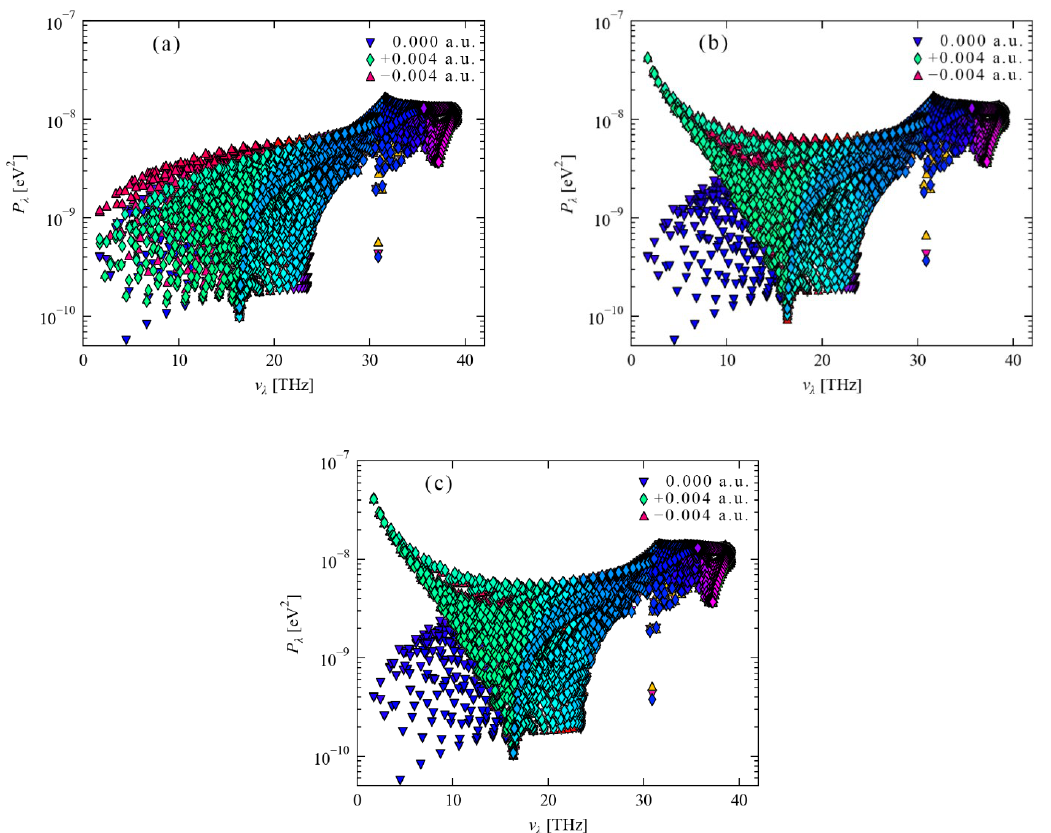
Figure 17. Phonon–phonon interaction strength after applying ± 0.004 a.u. electric fields in the [001], [110], and [111] crystallographic orientations of the diamond unit cell. Among them, ( a ) an electric field is applied in the [001] crystallographic direction, ( b ) an electric field is applied in the [110] crystallographic direction and ( c ) an electric field is applied in the [111] crystallographic direction. Figure 18 show the phonon lifetime density plots after applying different electric fields in the [001], [110] and [111] crystallographic orientations of diamond, respectively. The abscissa in the figure is the phonon frequency, the ordinate is the phonon lifetime, and the scale is the phonon density. The first row is a positive electric field, and the electric field strengths are 0.001 a.u., 0.002 a.u., 0.003 a.u. and 0.004 a.u. The second row is the